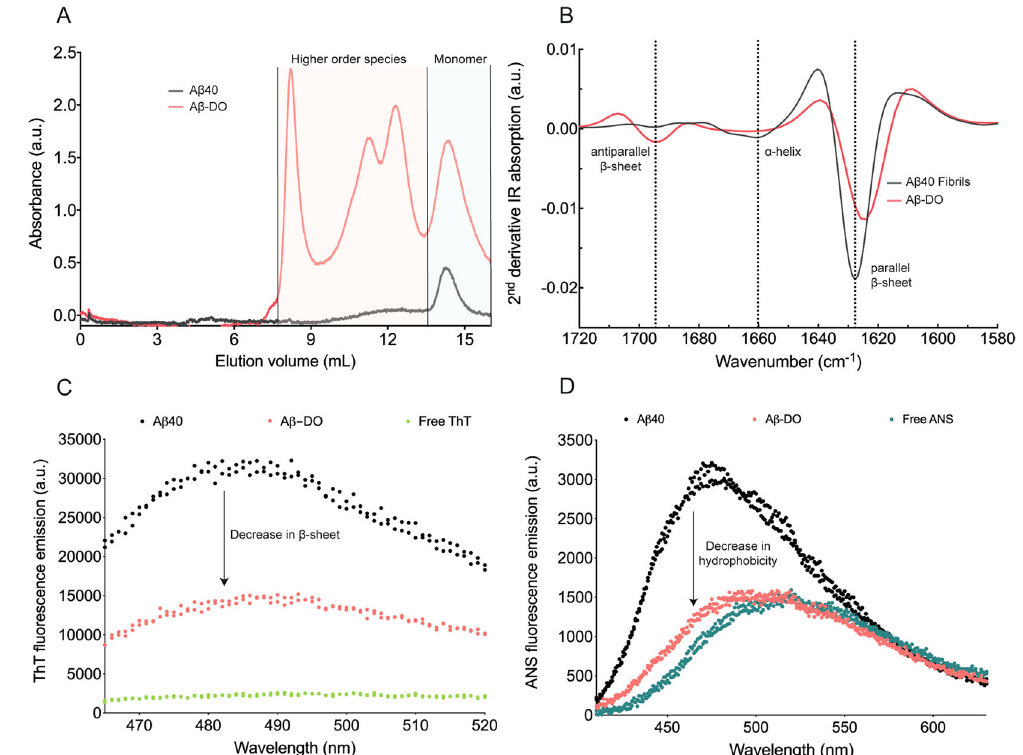
Fig. 4 Size distribution and structural characterisation of A β -DOs. a Size-exclusion chromatography pro fi les of A β 40-noDOs (black line) compared to A β -DOs (red line). b Second derivative of ATR-FTIR spectra of A β 40 fi brils (black line) and A β -DOs (red line). c Fluorescence emission spectra of ThT in the absence (green), or in the presence of A β 40-noDOs (black) or A β -DOs (red). d Fluorescence emission spectra of ANS in the absence (green), or in the presence of A β 40-noDOs (black) or A β -DOs